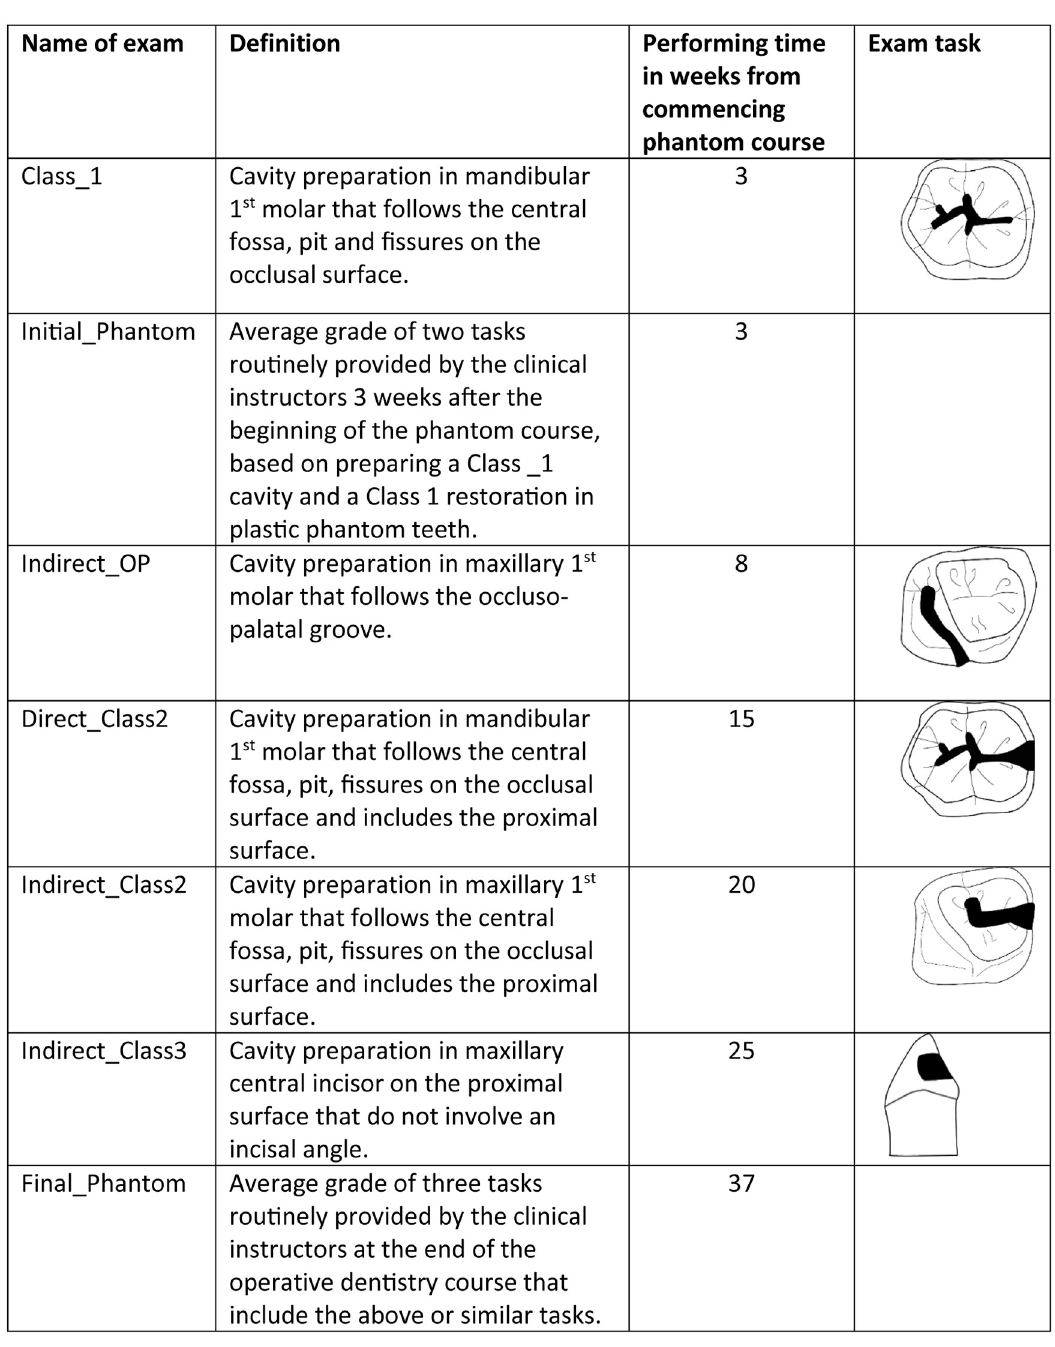
scale of 0–100 and the passing grade is 60. Since student identification numbers were coded, the instructors were blinded to their identity. The principal investigator who conducted the O’Connor test at the beginning of the study was blind to the students’ clinical grades for the phantom course. In addition, 2 other parameters were compared between the groups: the ini- tial phantom grade (Initial.Phantom) and the final phantom grade (Final.Phantom). Initial.